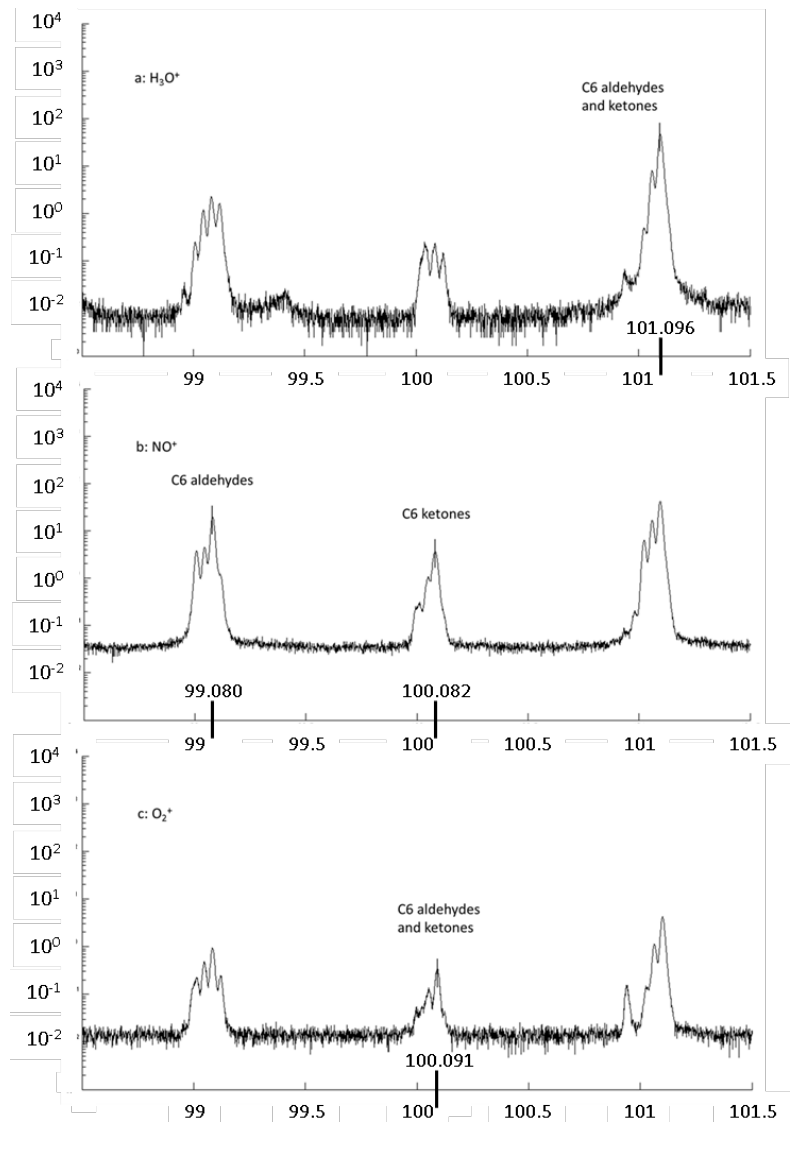
ketones measured by PTR-ToF-MS using different reagent ions. a: H Reprinted with permission from reference [63]. Copyright 2012 Elsevier